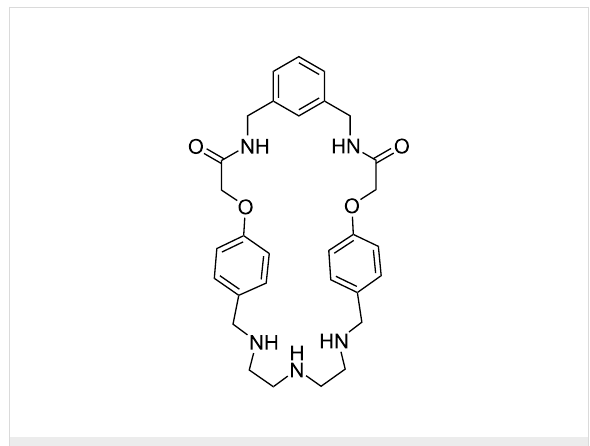
Figure 1: Bis-amido-tris-amine macrocycle